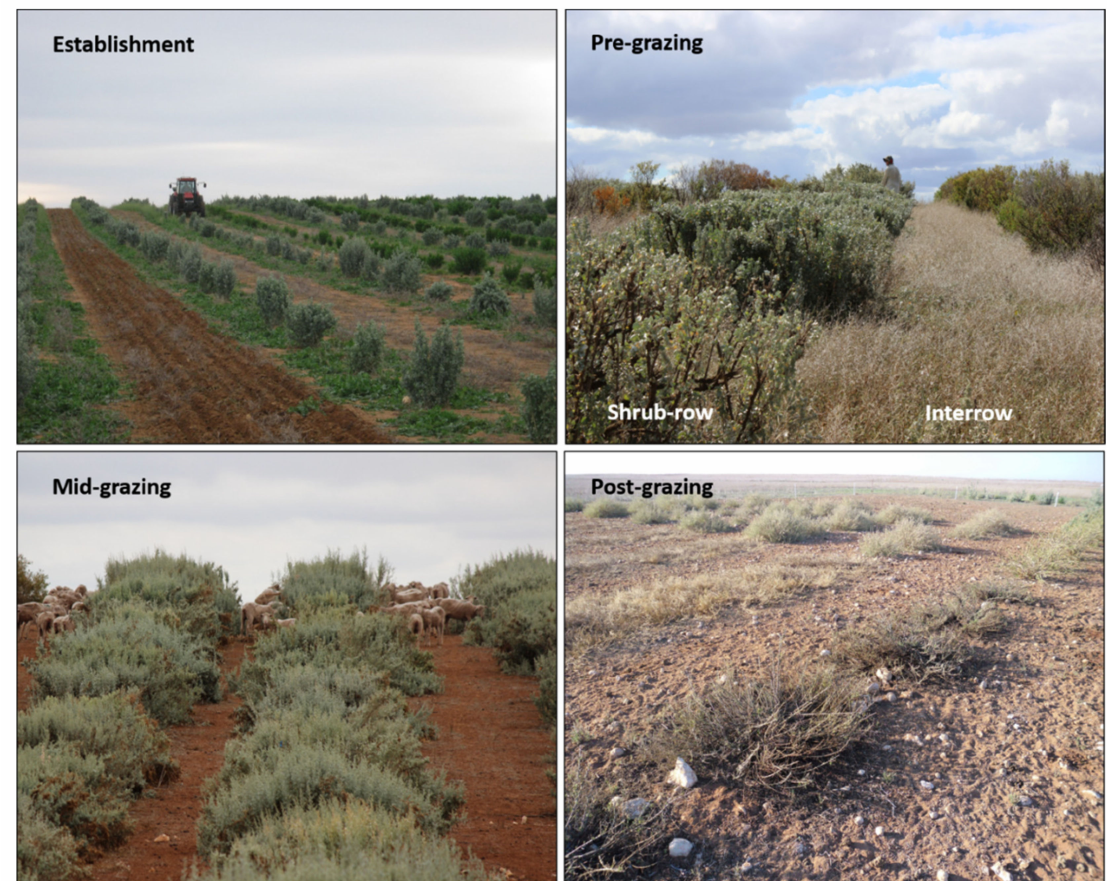
Figure 1. A forage shrub system typical of the arid lands, whereby shrubs are established as seedlings in rows and an interrow of plants is maintained.